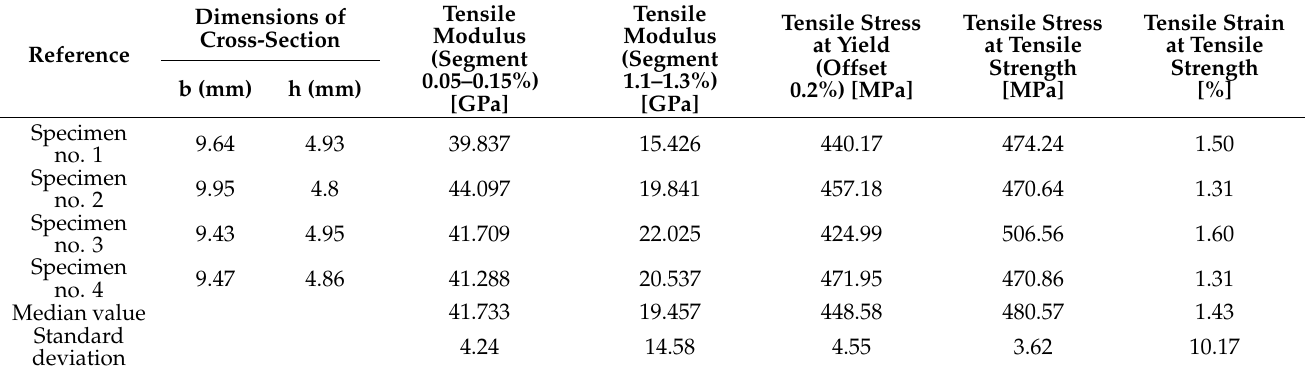
Table 3. Mechanical characteristics of multi-ply test specimens evaluated using INSTRON 8801.